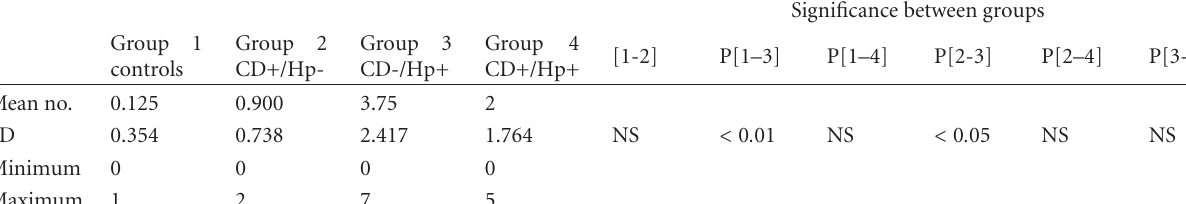
Table 3: Lymphoid aggregates in antrum.